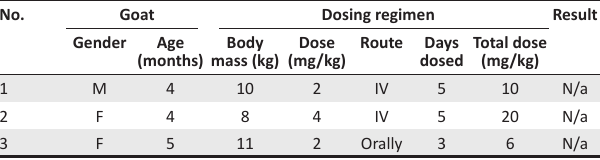
TABLE 1: Toxicity of diplodiatoxin for juvenile Saanen-cross goats. No. Goat Dosing regimen